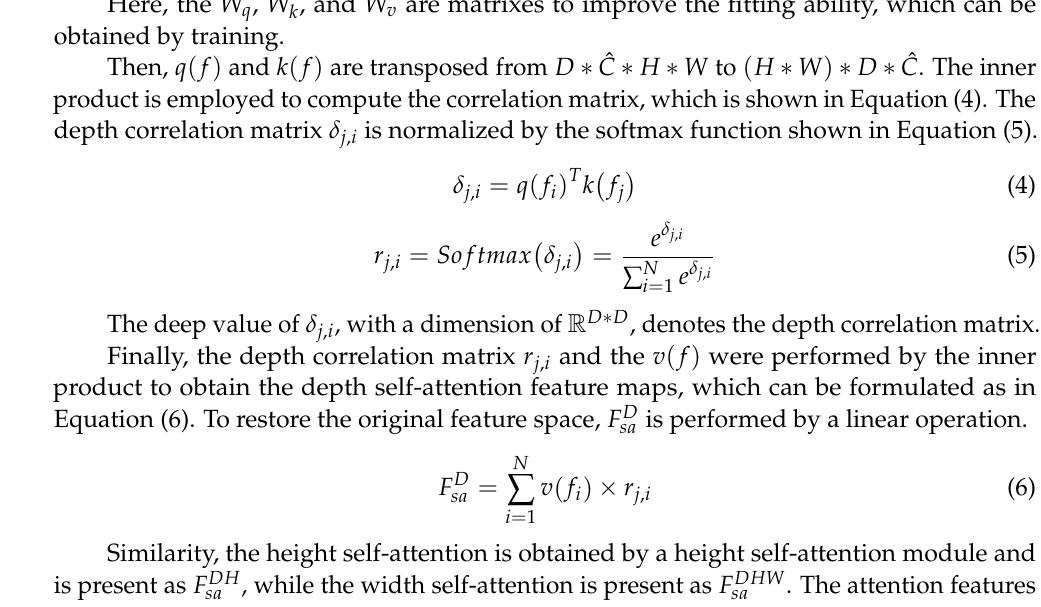
Figure 3. The structure of the proposed axial attention